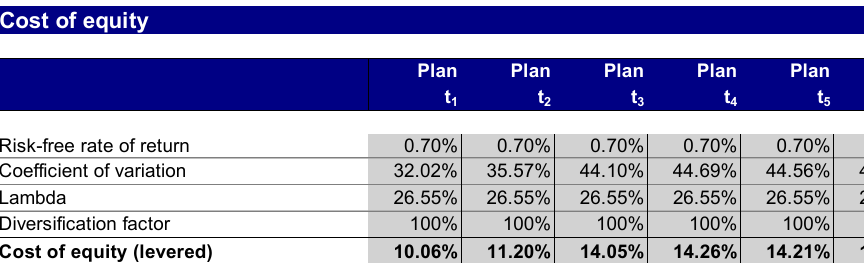
Figure 9. Derivation of the cost of equity for the risk premium method.